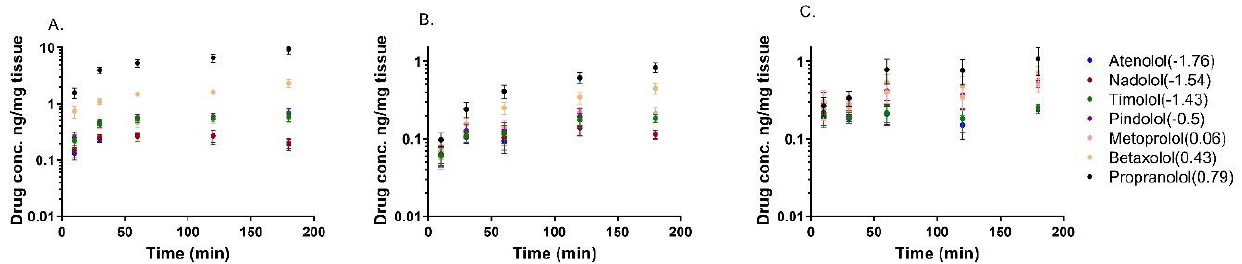
Figure 1. The concentrations of beta-blocking drugs (Log D 7.4 values are expressed inside parenthesis) in porcine corneal epithelium ( A ), corneal stroma ( B ), and conjunctiva ( C ) as a function of exposure time of drugs to the epithelial side of the isolated tissues. The results are expressed as mean ± standard error of the mean (SEM), n = 6 for cornea and n = 5 for conjunctiva. The drug concentration in the donor compartment was 2 ng/µL.